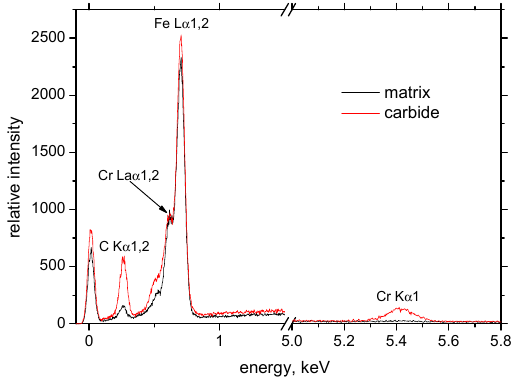
Figure 9. EDS analysis of matrix and carbide.